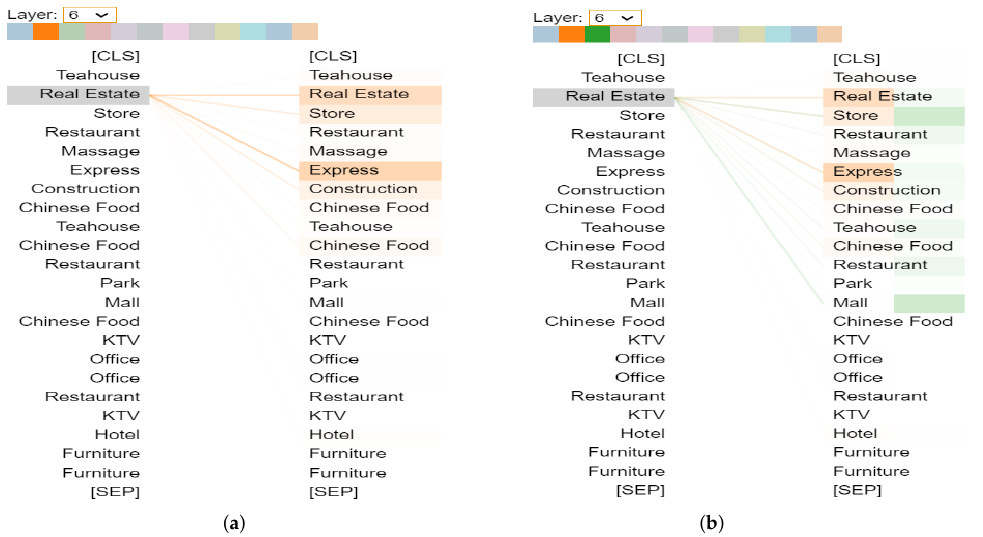
Figure 14. Pattern of long-distance dependencies. “Real Estate” is directed to itself and “Express” in ( a ). However, the attention is also dispersed over many different words which can be seen in ( b ). The color in the right sequence represents its corresponding head with yellow for Head 1 and green for Head 2: ( a ) attention weights for selected token “Real Estate” in Layer 6, Head 1; ( b ) attention weights for selected token “Real Estate” in Layer 6, heads 1 (orange) and 2